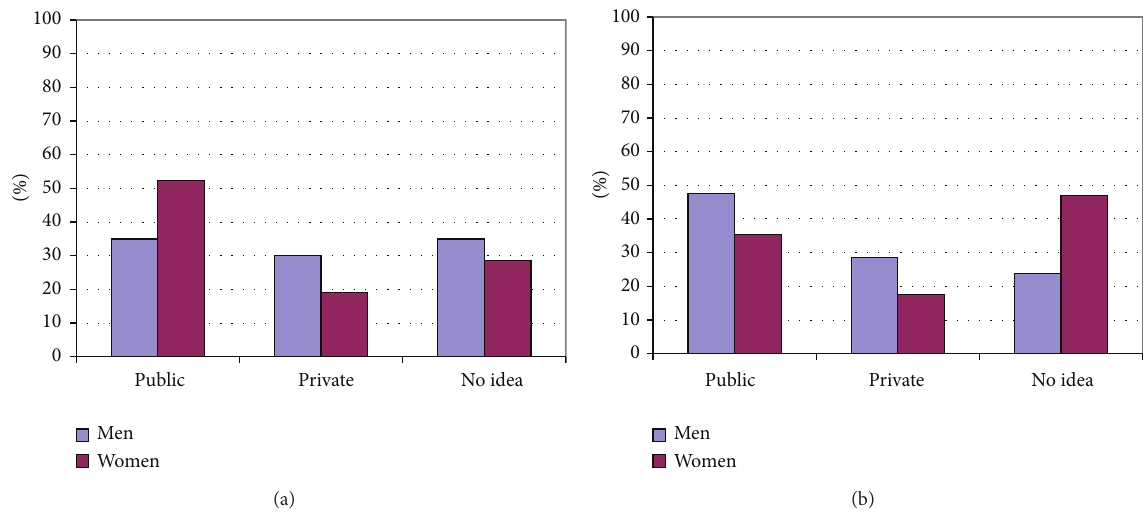
Figure 7: Type of personal profile over Instagram: DN (a) versus DI (b).